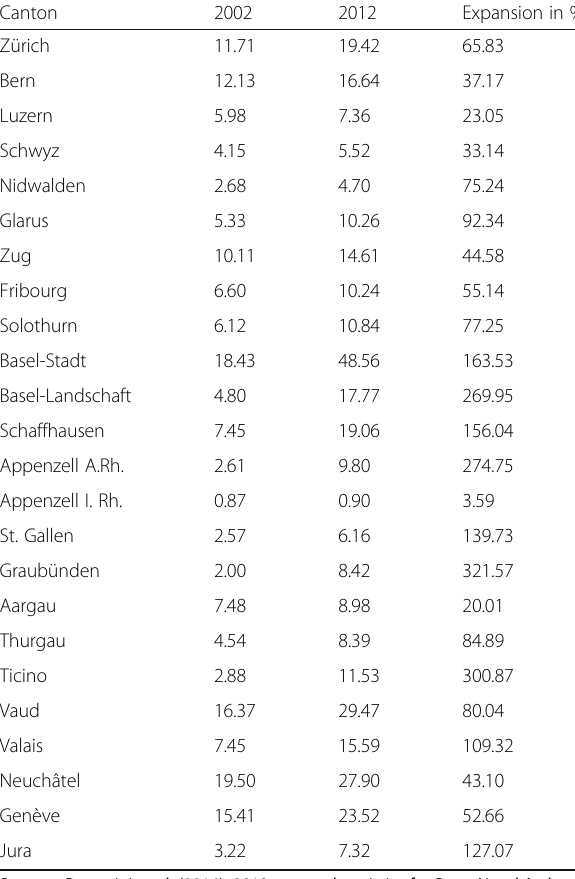
Table 9 Child-care coverage across cantons, 2002 and